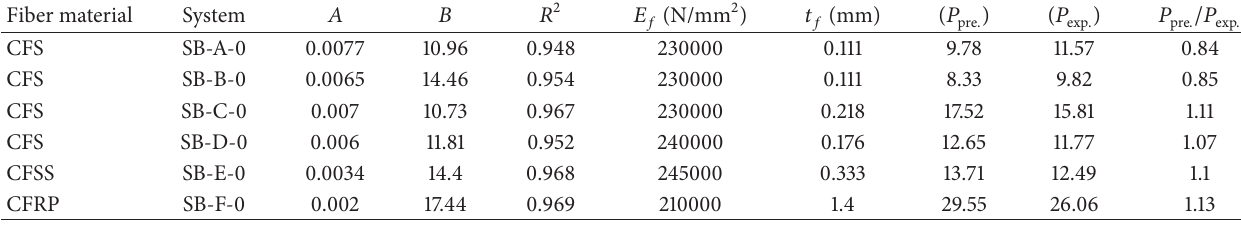
Table 1: Verification of Dai’s approach using different FRP bonding